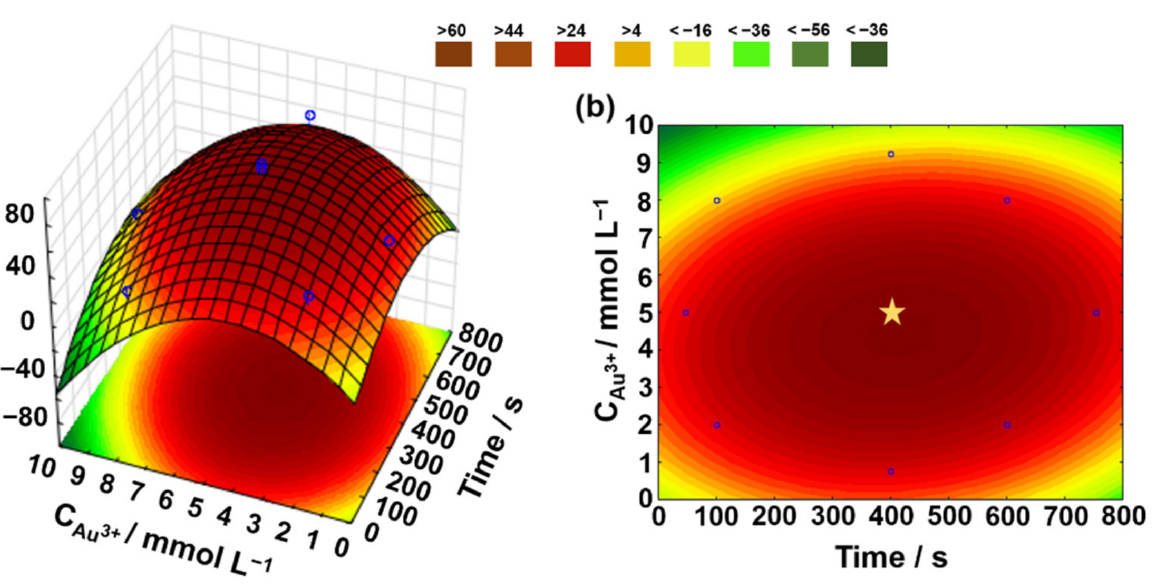
Figure 3. ( a ) Surface response and ( b ) level curve obtained for the optimization of the variables: Au 3+ concentration (mmol L − 1 ) and electrodeposition time (s) as a function of the current in the presence of 3.0 mmol L − 1